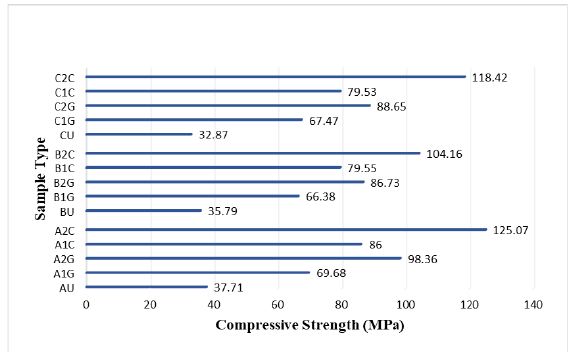
Figure 7: Bar-chart of compressive strength of CFRP/GFRP confined polymer